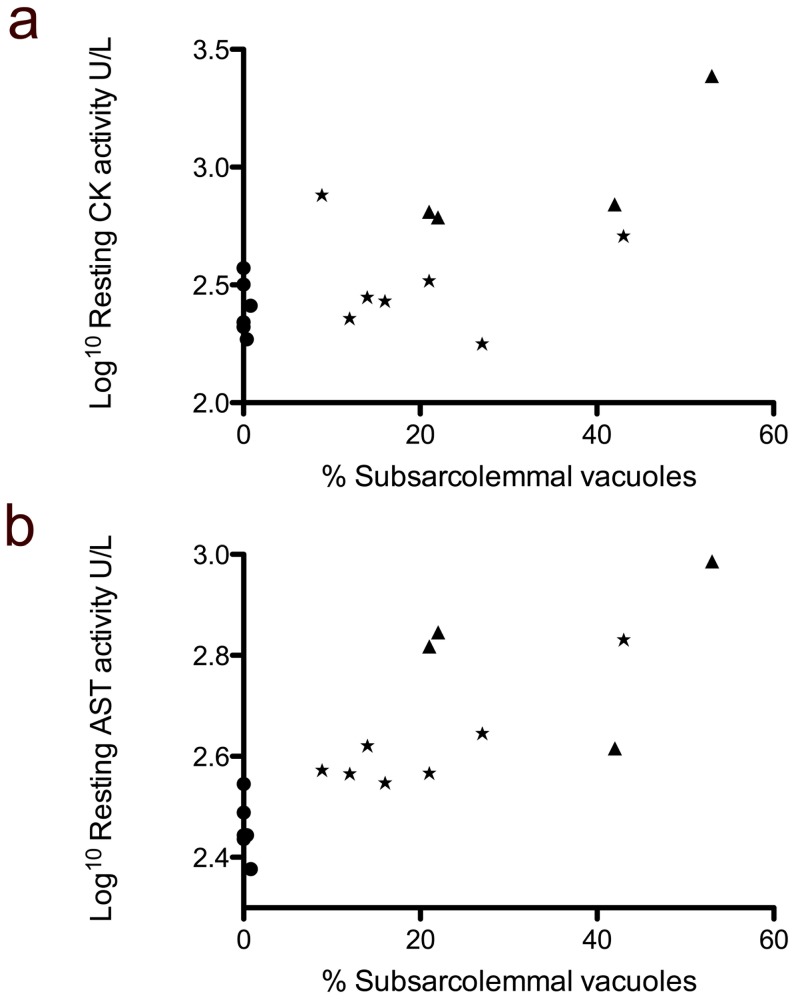
The correlation between muscle enzyme activity and muscle histopathology.Scattergraphs illustrating the correlation between the Log10 resting CK activity (A) and Log10 AST activity (B) and the percentage of fibres containing subsarcolemmal vacuoles. (HH = triangles, HR = stars, RR = circles) (n = 18).